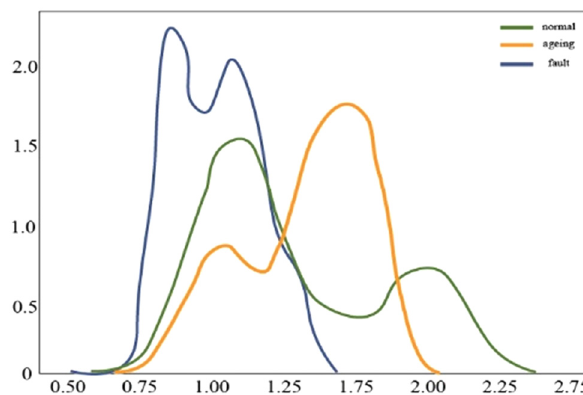
Figure 5: EDR probability density curve.